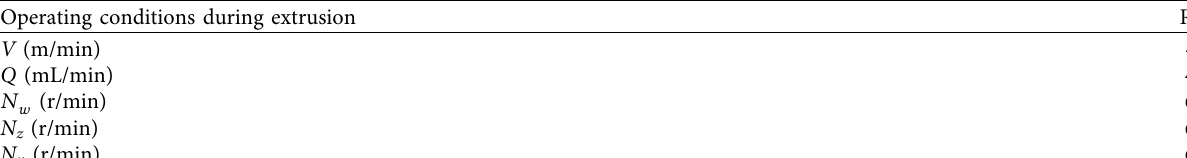
Table 2: Range of operating conditions.